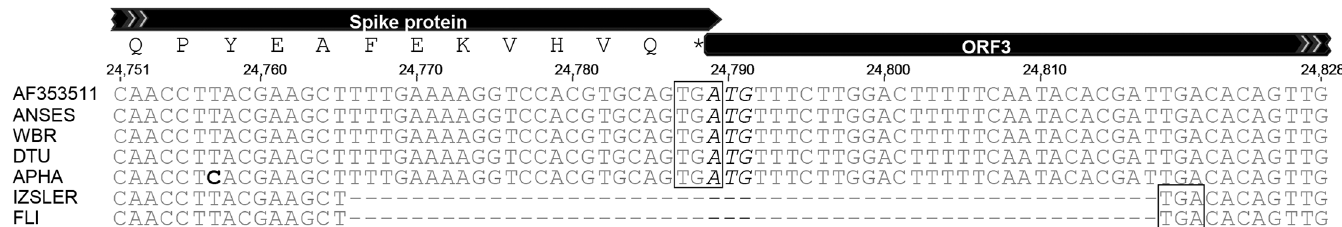
Fig 2. Identical deletions at the junction of the S protein and ORF3 protein coding regions in two PEDV strains. The PEDVs sequenced by IZSLER and FLI have identical 52 nt deletions which removes the usual termination codon (marked in a box). This can be predicted to result in the removal of 7 amino acids from the C- terminus of the spike protein and the use of a different termination codon (marked in another box) but no extraneous residues will be added to the S protein. In addition, this deletion removes the initiation codon for ORF3 (indicated in italics), which can be expected to result in complete loss of ORF3 protein expression. A single, non-synonymous, nt change (T24757C, resulting in a Y to H substitution) is present in the APHA sequence and is indicated in bold type.